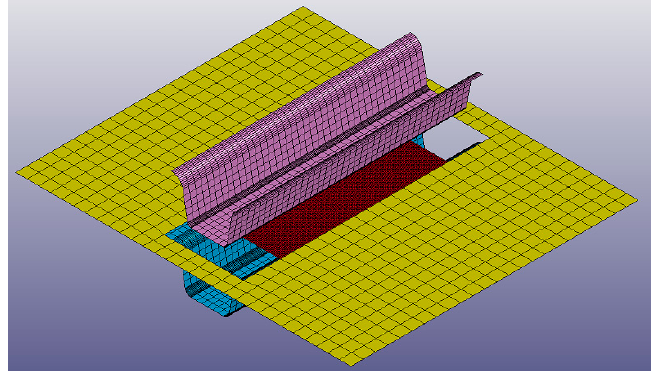
Figure 5. Mesh model. Table 4. Physical and thermal parameters of the blank and tools (400 °C).